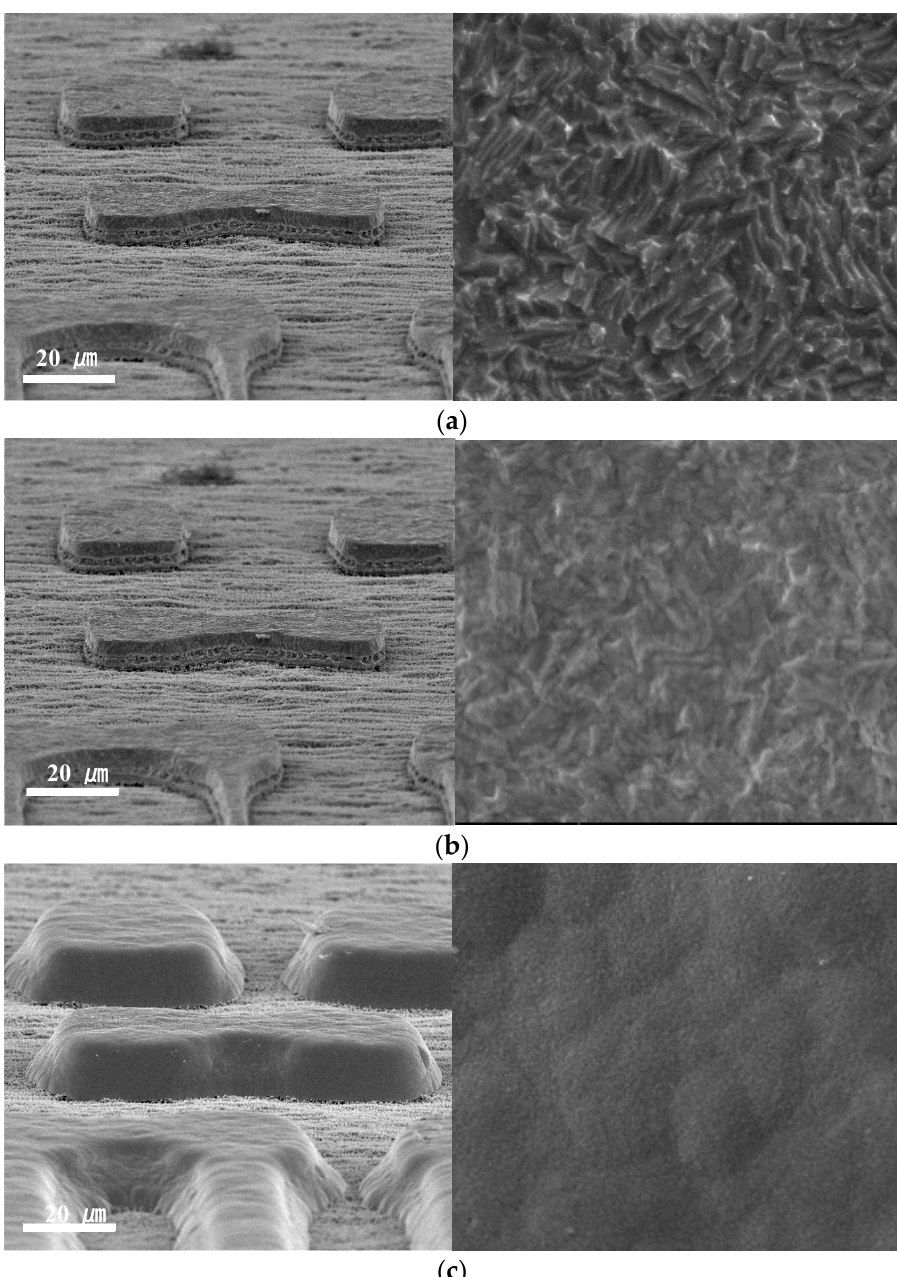
Figure 7. Scanning electron micrographs of ( a ) bare Cu, ( b ) EPIG, and ( c ) ENEPIG. Left images show tiled view, and right images show the enlarged top view of the surface finishes. The surface topographies and the line profiles of the soft‑etched bare Cu pad and surface‑finished pads were observed with AFM and shown in Figure 8. From the surface topographies, the surfaces of the EPIG and ENEPIG finishes were smoother than the soft‑ etched Cu pad, which indicated that the surface finish process clearly lowered the surface roughness of the Cu pad. From the line profile measurement, the root‑mean‑square (RMS) roughness values of the bare Cu pad, EPIG, and ENEPIG finishes were approximately 90, 82, and 50 nm, respectively, which was evaluated from the line profile in Figure 8.